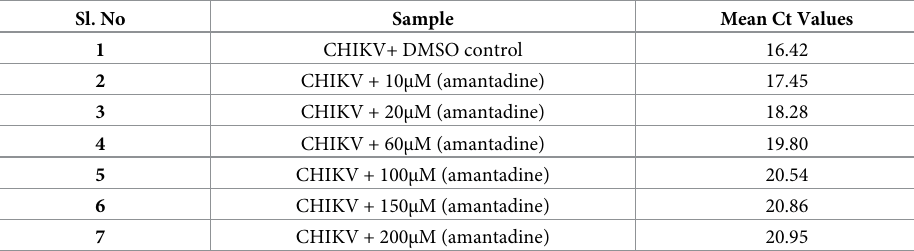
Table 1. qRT-PCR analysis of the effect of amantadine inhibition on CHIKV (S 27) infection. Sl.